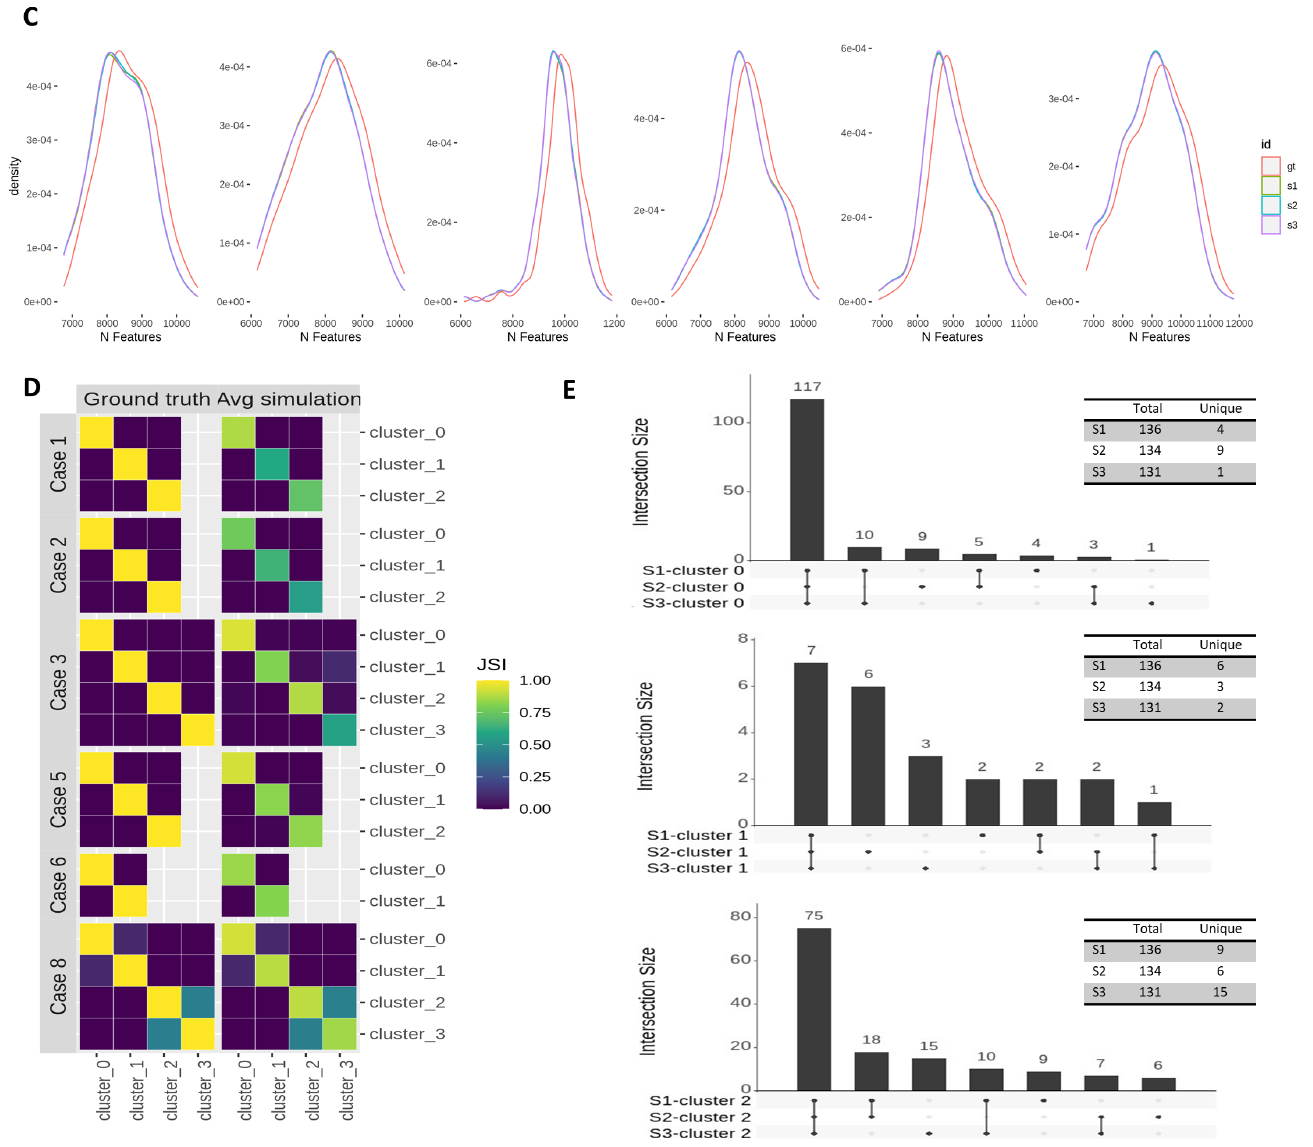
Figure 2. Sample splitting across sequencing lanes introduces variability that is propagated to downstream analysis in Smart-seq2 scRNA-seq data. ( A ) UMAP representation of the Cuomo dataset. Cells are coloured according to their donor (left), time-point (central) and cluster (right). For the different study cases considered, we show: ( B ) number of unique reads distribution for the ground truth and simulations; ( C ) number of feature distributions for the GT and S samples; ( D ) cluster similarity for each study case as evaluated using the JSI calculated on the set of DE features obtained per cluster. The values across the 3 simulations were averaged using the geometric mean. ( E ) Variability of differentially expressed feature set and number of unique DE features across simulations for cluster 0 (upper), 1 (central) and 2 (lower) for Study Case